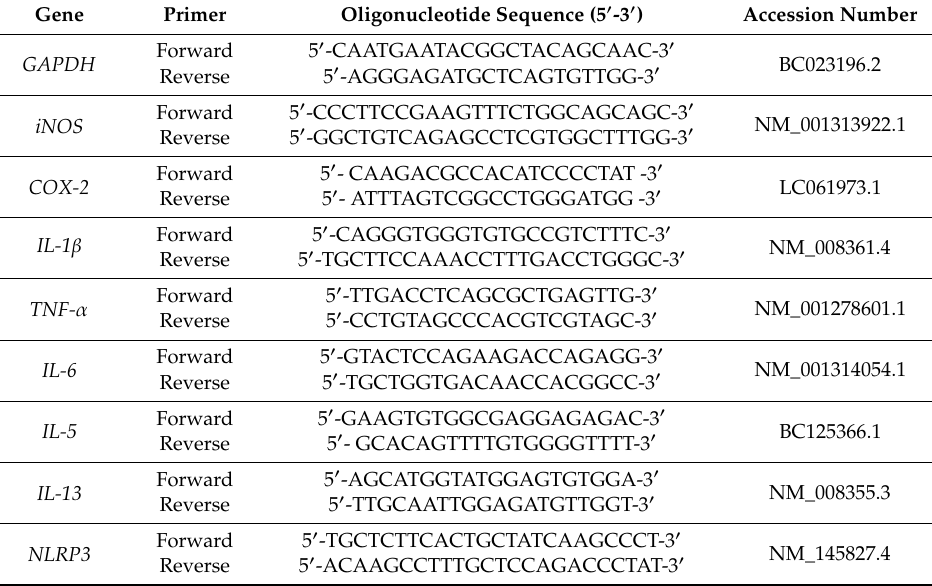
Table 2. Primer sequences used in this